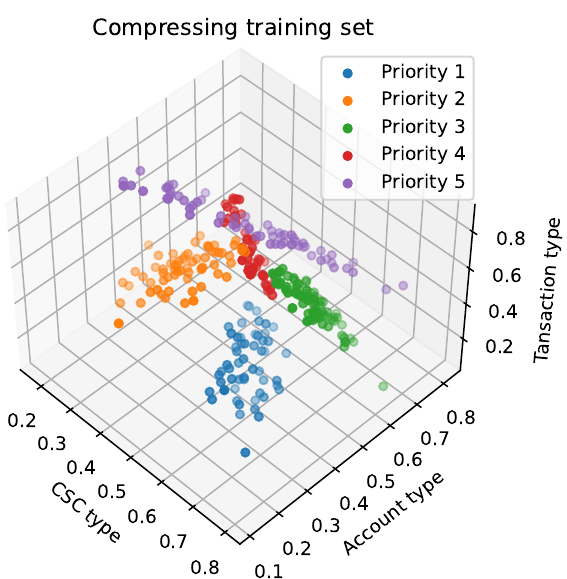
Figure 14. Compressing training set scatter